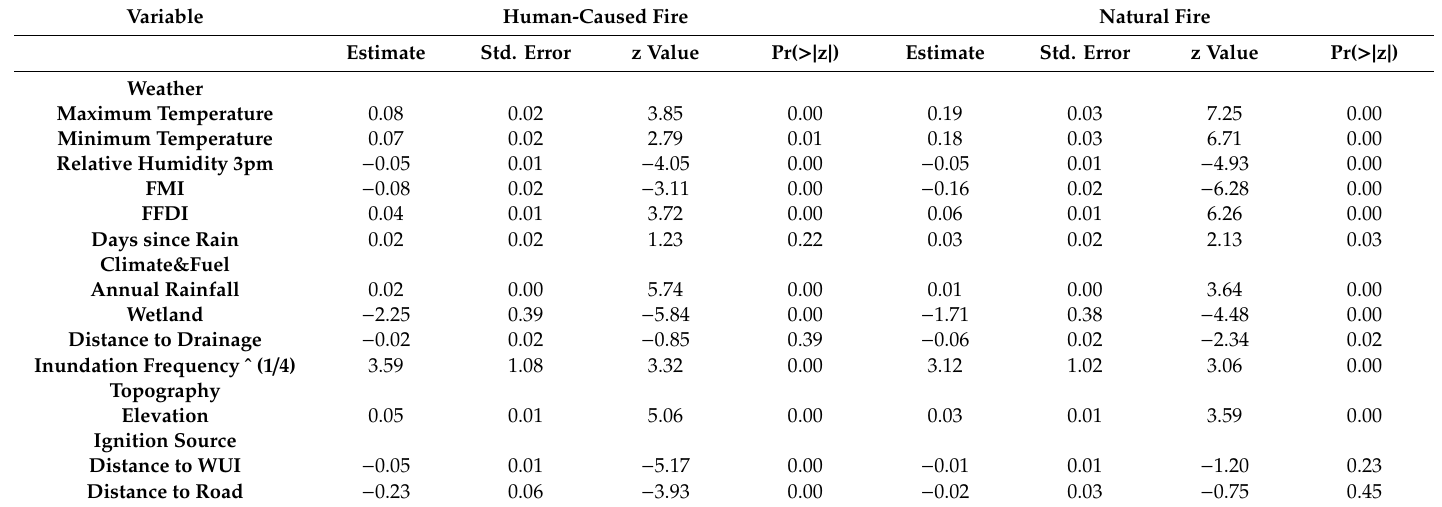
Table 3. Results of univariate models for human-caused and natural fires.